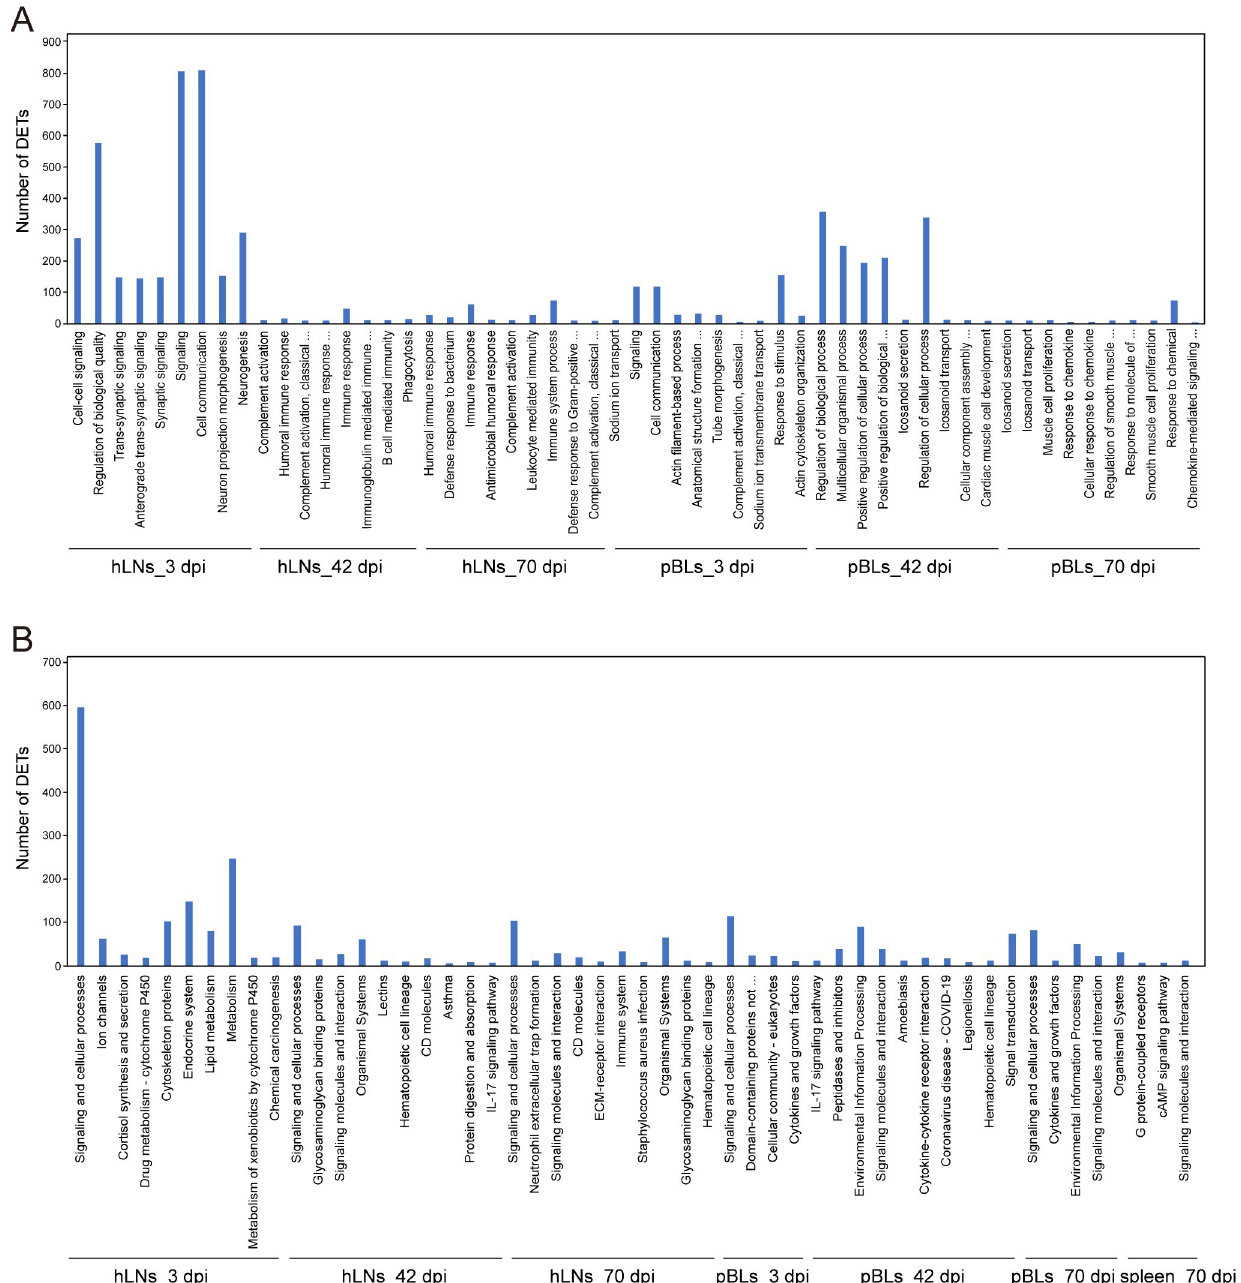
Fig 2. Bar plots showing the results of GO enrichment (A) and KEGG analysis (B) of DETs in tissues of the infected buffaloes.